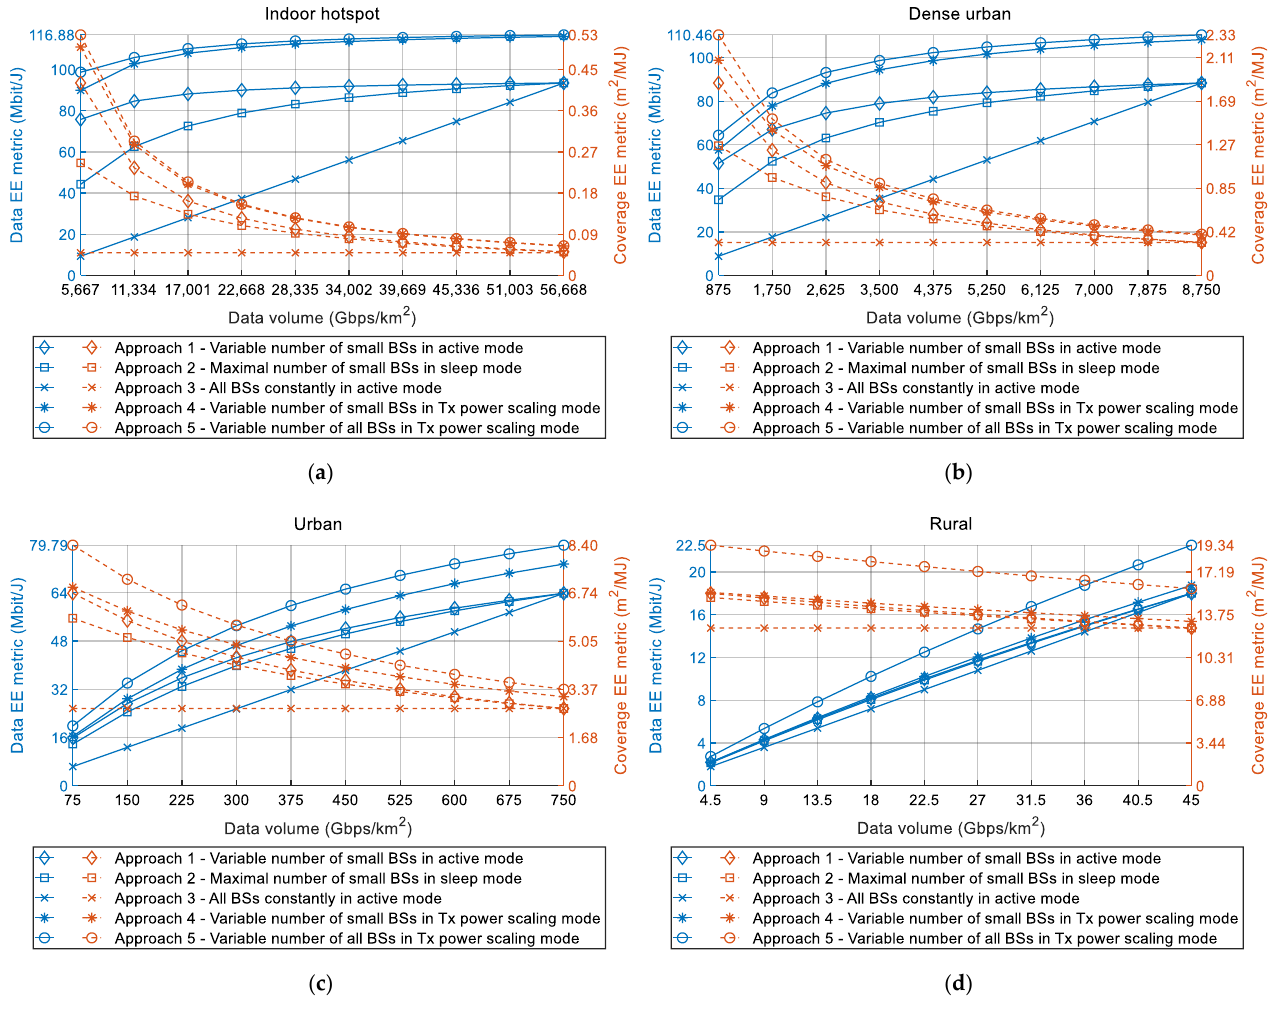
Figure 2. Impact of DV increase on data and coverage EE metrics for each year during the 2020s for ( a ) indoor-hotspot, ( b ) dense-urban, ( c ) urban and ( d ) rural device density class.